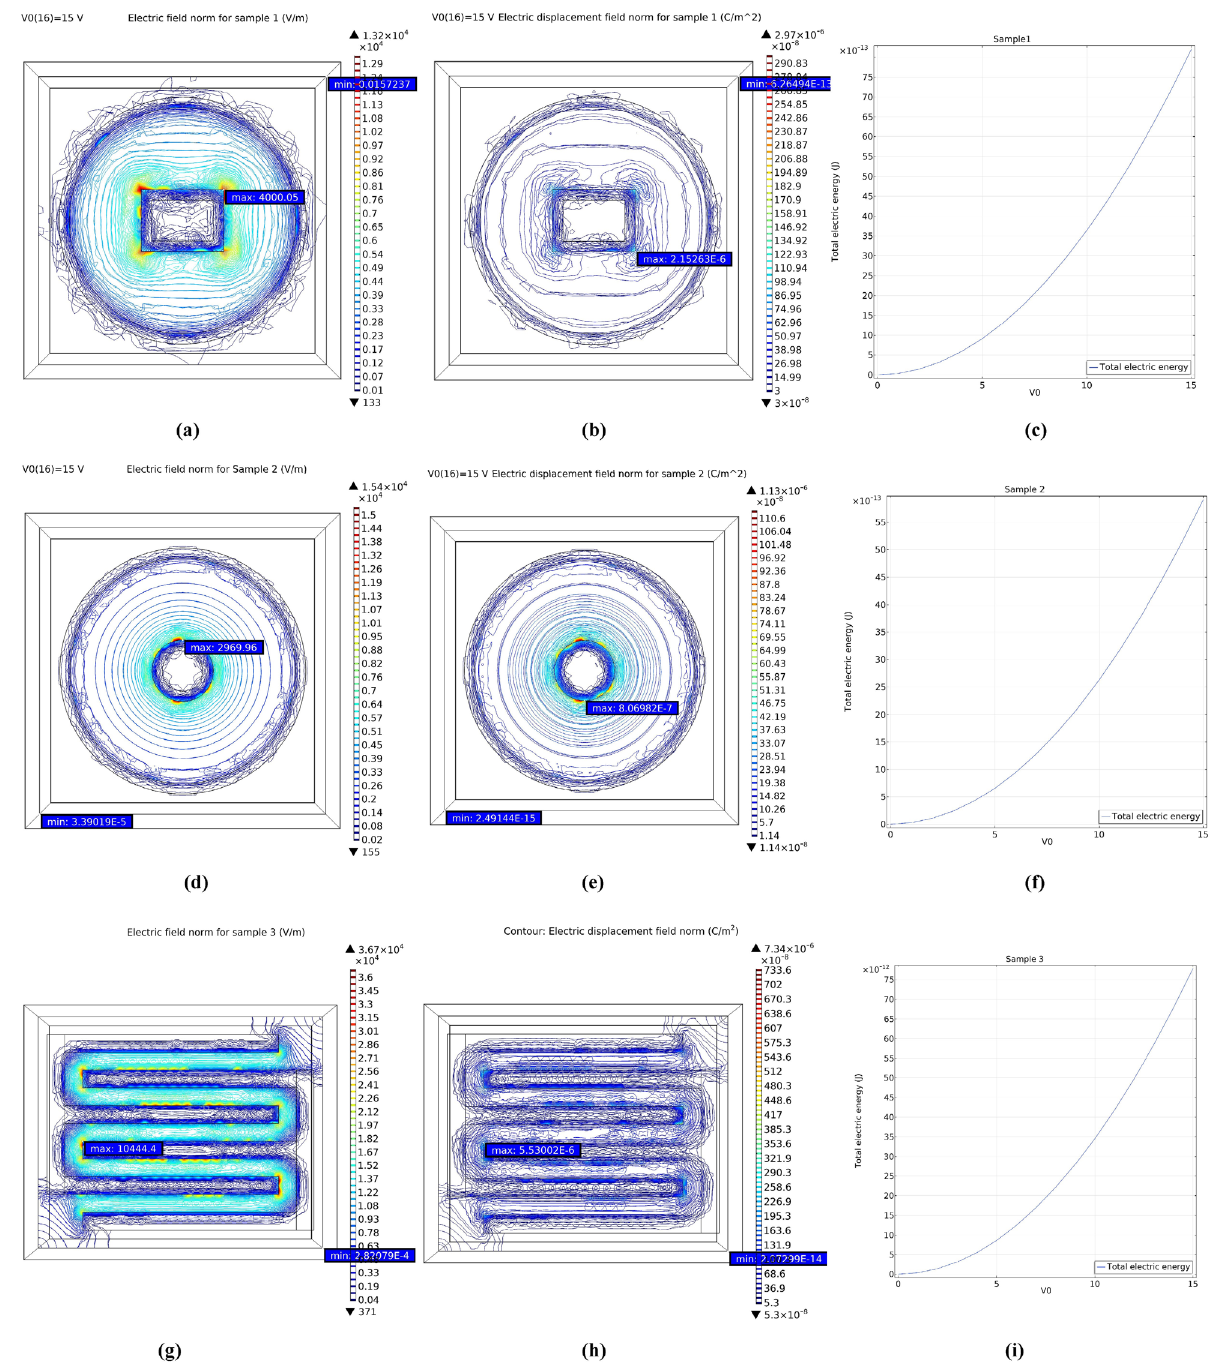
Figure 9. Simulation in COMSOL multiphysics software (a) electric field norm for sample 1 at 15 V bias, (b) electric displacement field norm for sample 1 at 15 V bias, (c) total electric energy for sample 1 at 0 to 15 V bias, (d) electric field norm for sample 2 at 15 V bias, (e) electric displacement field norm for sample 2 at 15 V bias, (f) total electric energy for sample 2 at 0 to 15 V bias, (g) electric field norm for sample 3 at 15 V bias, (h) electric displacement field norm for sample 3 at 15 V bias, (i) total electric energy for sample 3 at 0 to 15 V